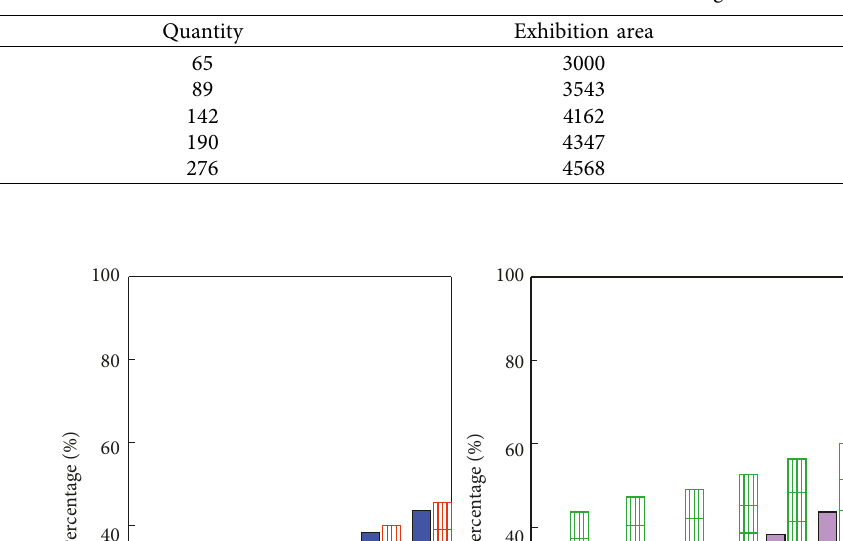
Table 2: 2013–2017 exhibitions with the theme of animation games.